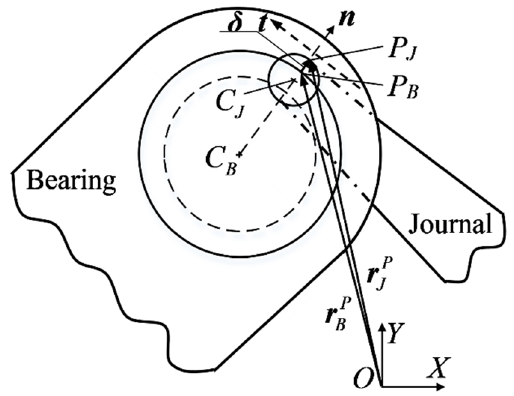
Figure 2. Collision model at the clearance joint.